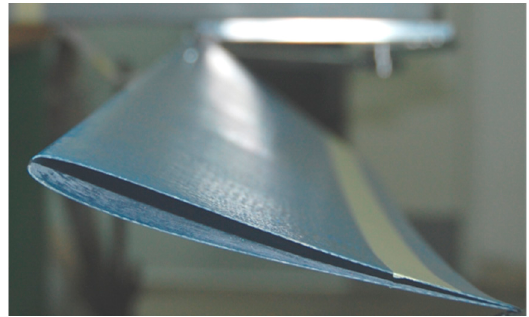
Figure 16. A view from the tip of the twisted wing, at Re = 30,000, AOA = 15°.